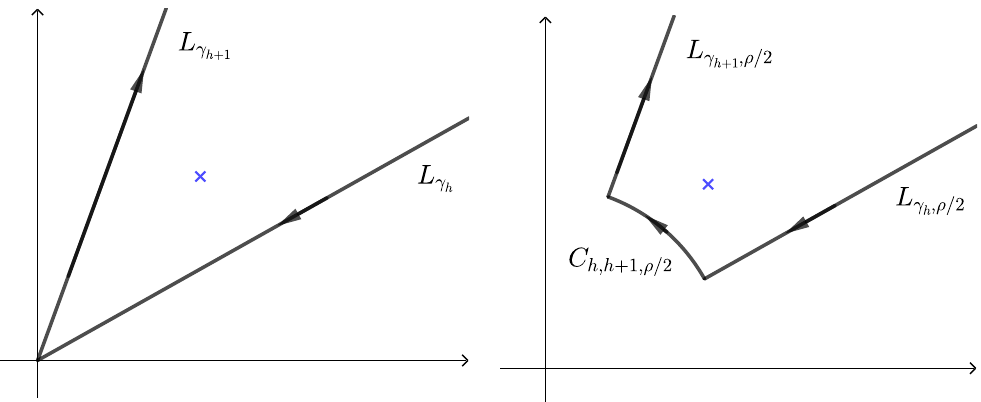
Figure 1. Initial ( left ) and deformed path ( right ) for the difference of two consecutive solutions of (17). The symbol “ × ” represents a root of P m ( τ )